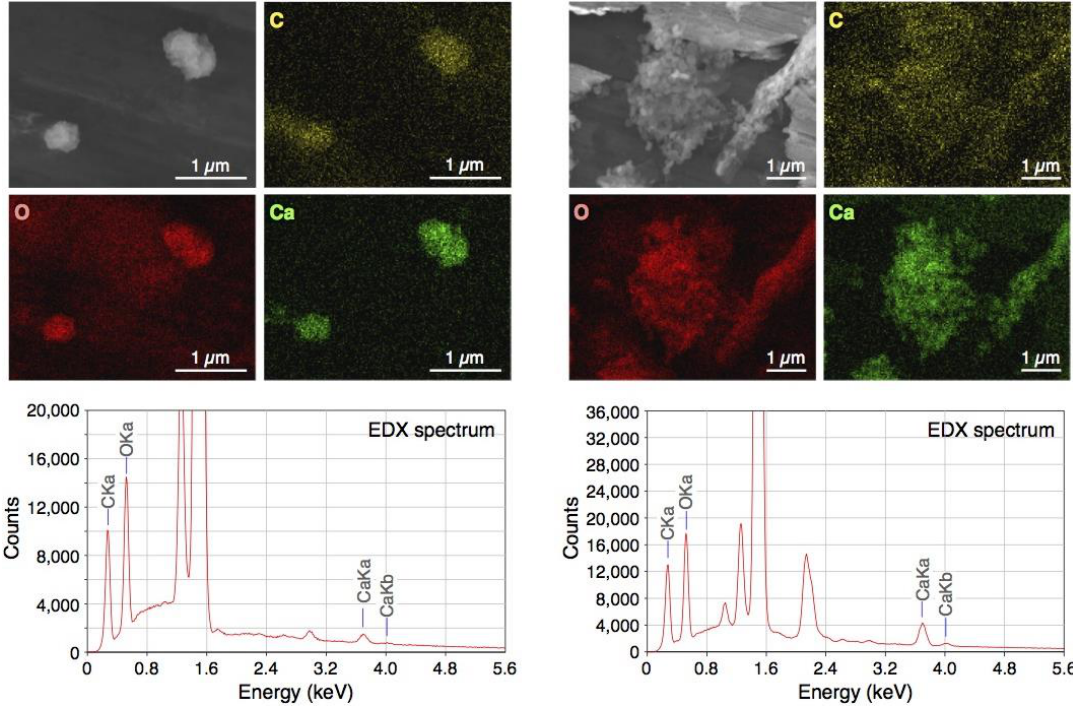
Figure 1. Scanning Electron Microscopy (SEM) and energy dispersive X-ray (EDX) elemental mapping images and EDX spectra of freeze-dried bioshell calcium oxide (BiSCaO) Water. Two different regions of the sample were analyzed (left and right). Yellow, red, and green pictures show the presence of carbon, oxygen, and calcium, respectively, by EDX elemental mapping.